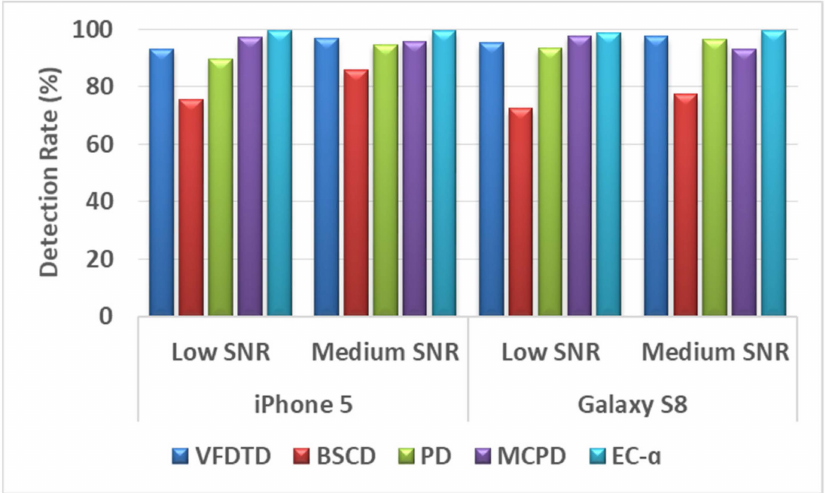
Figure 5. Transient starting point detection accuracy of the methods for Wi-Fi signals with leading response at low and medium SNR.